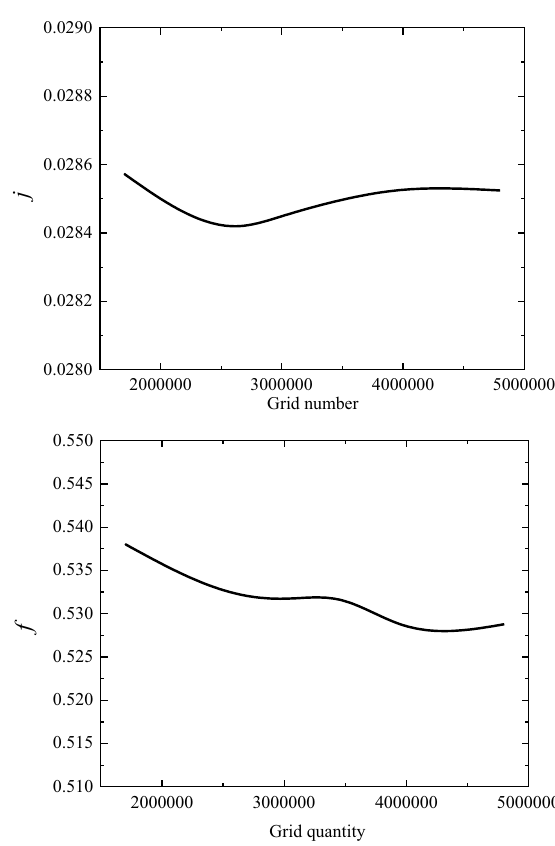
Figure 4 Variation of j factor and f factor with the number of grids